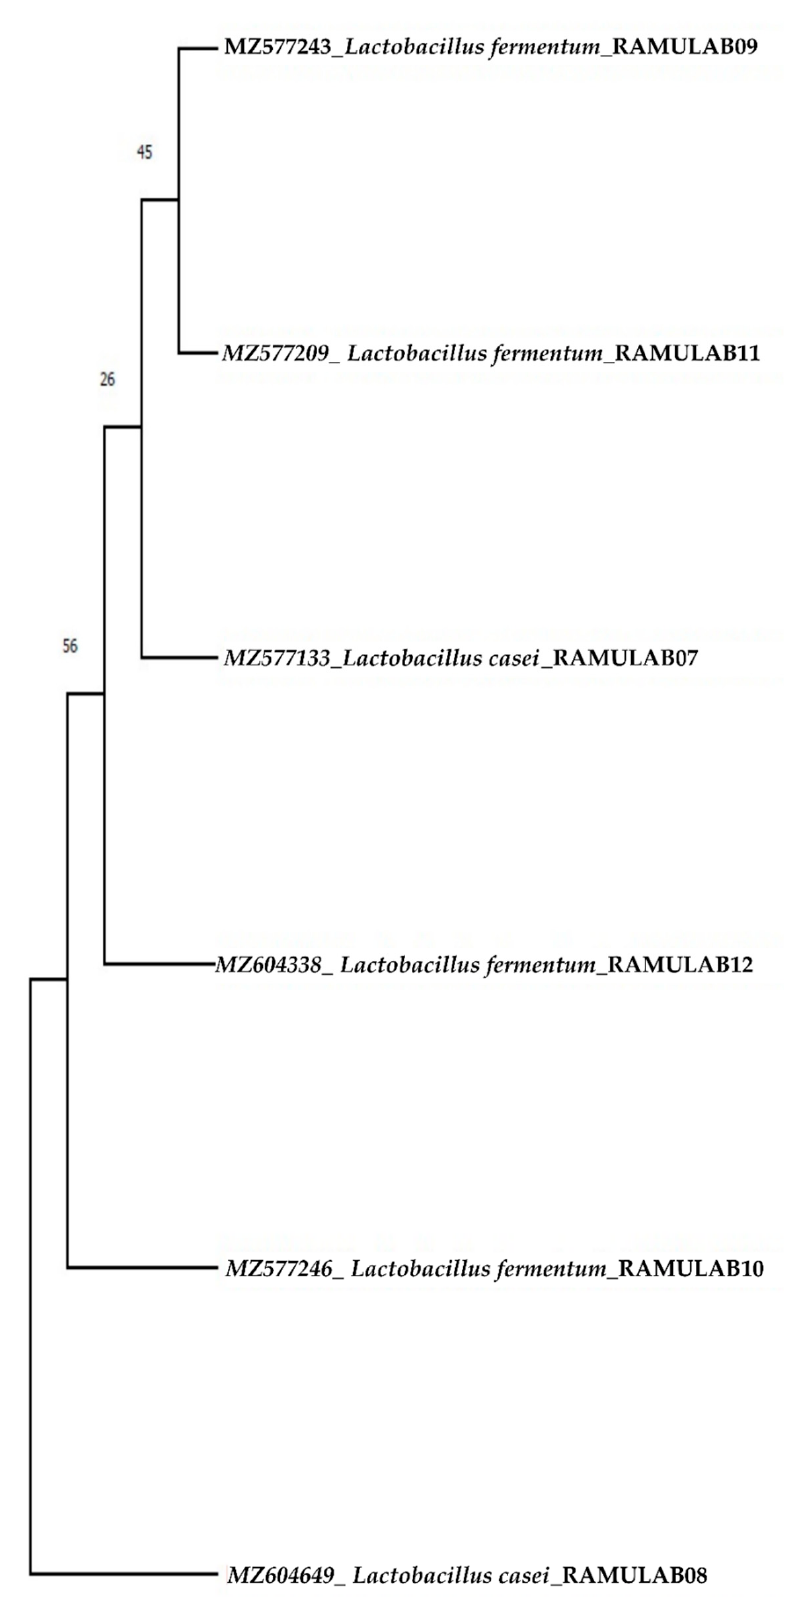
Figure 5. Phylogenetic tree of LAB isolates (RAMULAB07–12) from dosa batter samples based on maximum likelihood bootstrap analysis of 16S rDNA.